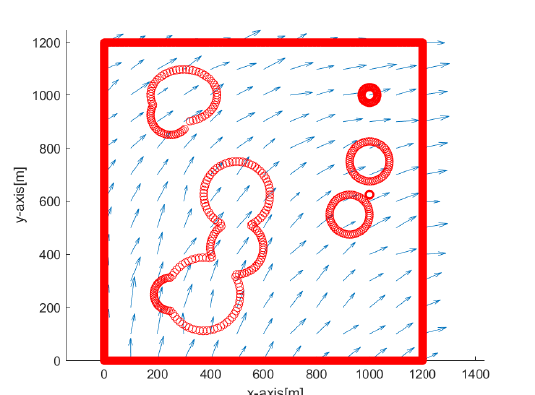
Figure 3. The origin of the rectangular workspace is located at the left bottom corner of the workspace. Blue arrows show the perturbation vector field that is irregularly generated in the environment. Obstacle boundaries are depicted with red circles.